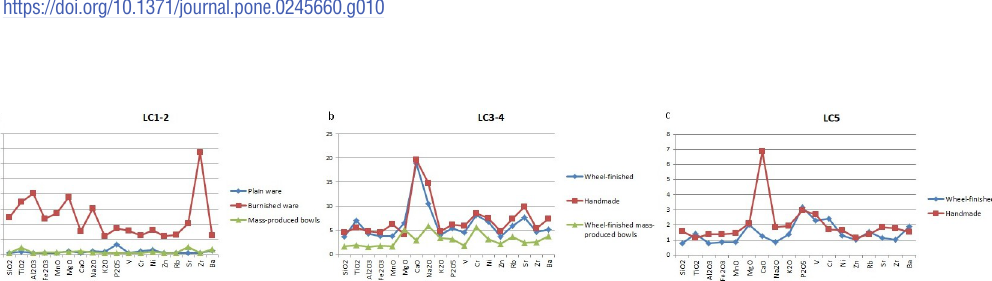
Fig 10. Relationships between elemental CVs and ceramic wares/manufacturing techniques found in the LC1-2 (a), LC3- 4 (b) and LC5(c).